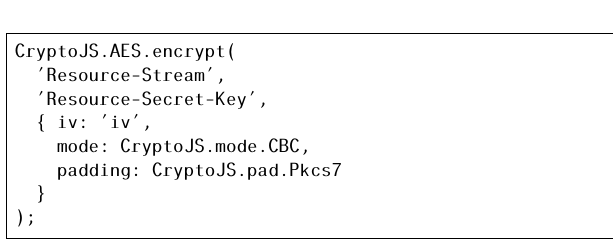
Figure 12. Javascript AES encipher